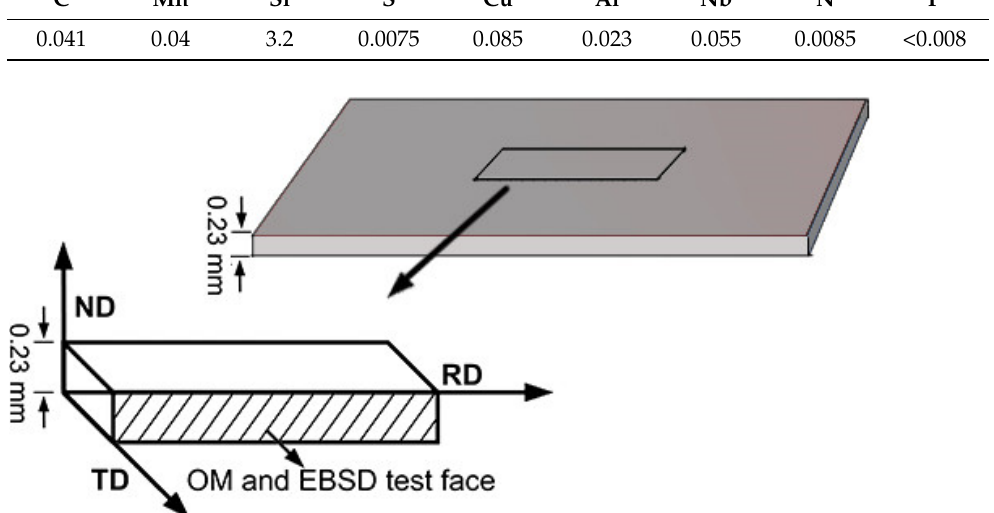
Figure 1. Schematic diagram of sampling position and the observation plane NDxRD.